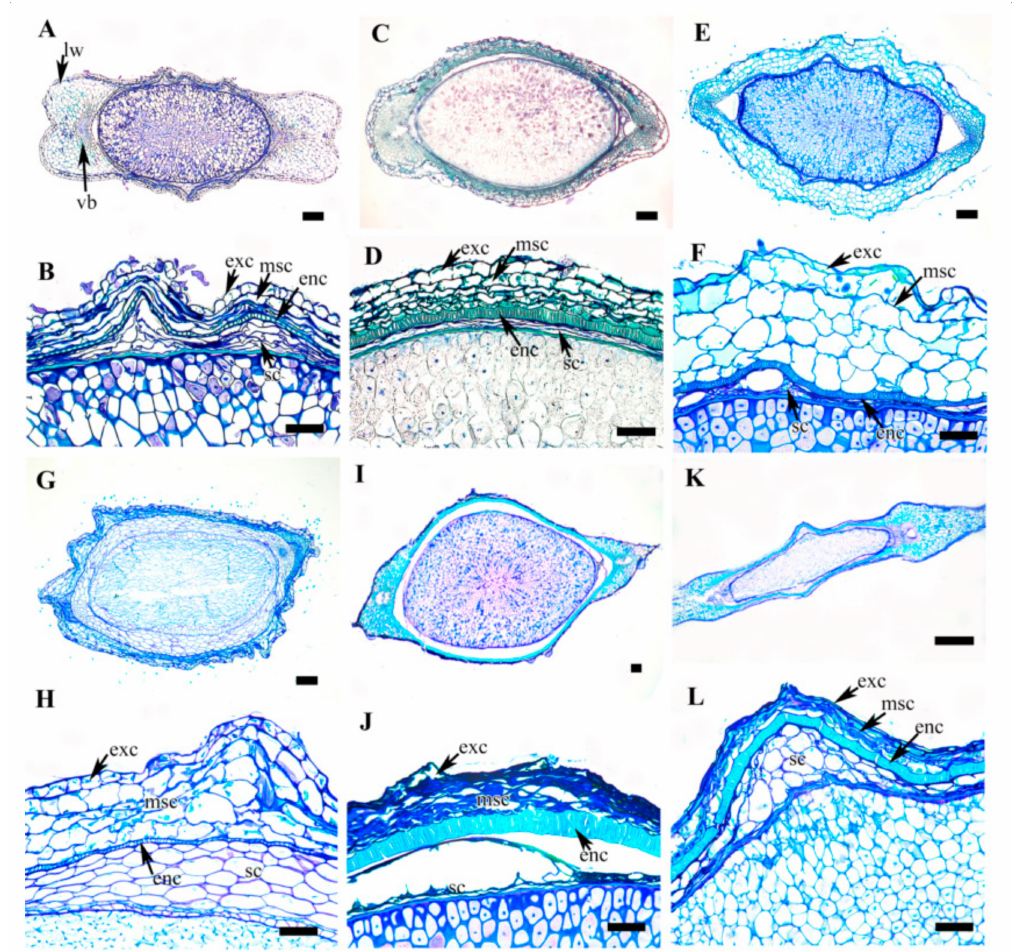
Figure 6. Cross section of achenes of Clematis . ( A , B ) C. terniflora var. mandshurica . ( C , D ) C. heraclefolia . ( E , F ) C. urticifolia . ( G , H ) Clematis takedana . ( I , J ) C. patens . ( K , L ) C. brachyura . Abbreviations: enc, endocarp; exc, exocarp; lw, lateral wing; msc, mesocarp; sc, seed coat; vb, vascular bundle. Scale bars: 1 mm (K), 200 µ m ( A , C , E , G , I ); 100 µ m ( B , D , F , H , J , L